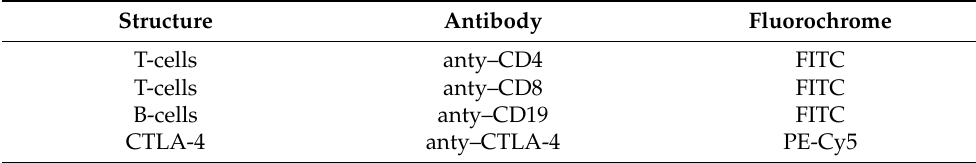
Table 4. List of antibodies used to assess lymphocyte